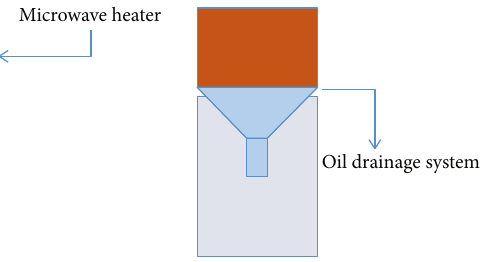
Figure 3: Schematic of the gravity drainage test of heavy oil under microwave